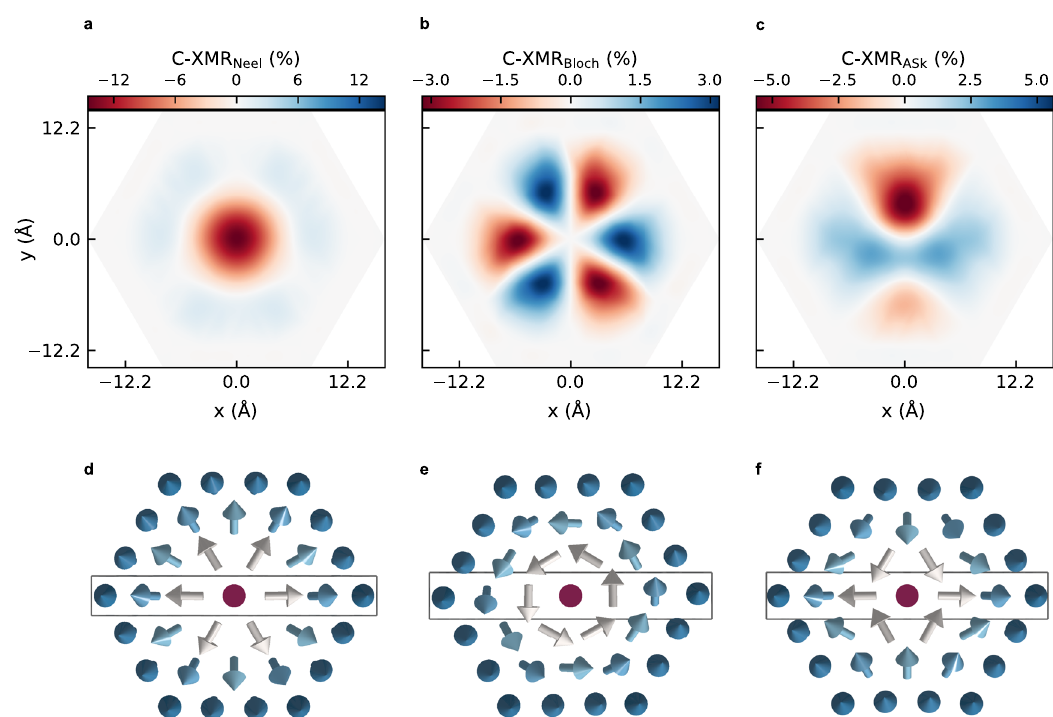
Fig. 5 C-XMR signals on various chiral skyrmions. On the upper panel the C-XMR signal at a bias energy of eV bias = 1.27 eV is shown for ( a ) Néel type and ( b ) Bloch type skyrmions and for ( c ) antiskyrmions. On the lower panel d - f the corresponding skyrmion magnetic textures with diameter D sk ≈ 2.2 nm are shown. The rectangular boxes are used in the text to address the change of chirality across the different